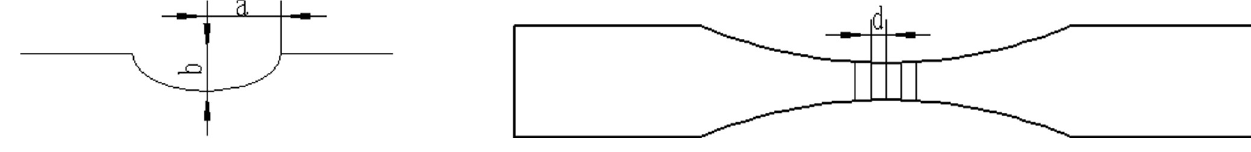
Fig 2. Geometry and dimension of surface